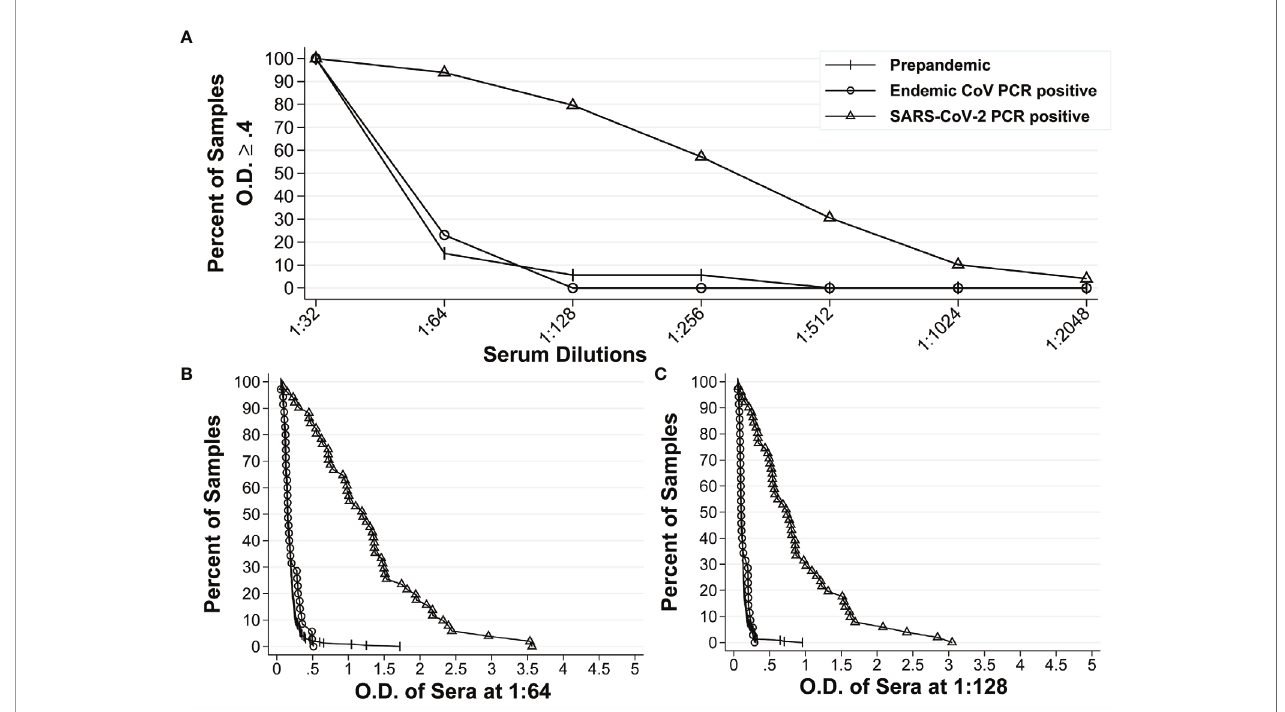
FIGURE 2 | Reverse cumulative distribution curves of IgA anti-S ELISA. (A) Percentages of positive sera among the pre-pandemic sera with unknown infectious status to endemic coronaviruses (n = 234), pre-pandemic human endemic coronavirus PCR positive sera (n=35), and SARS-CoV-2 PCR positive sera (n=51) at different dilutions at an O.D. ≥ 0.4. (B, C) Percentages of positive sera at different O.D. values for all three groups of sera at 1:64 dilution and 1:128 dilution,